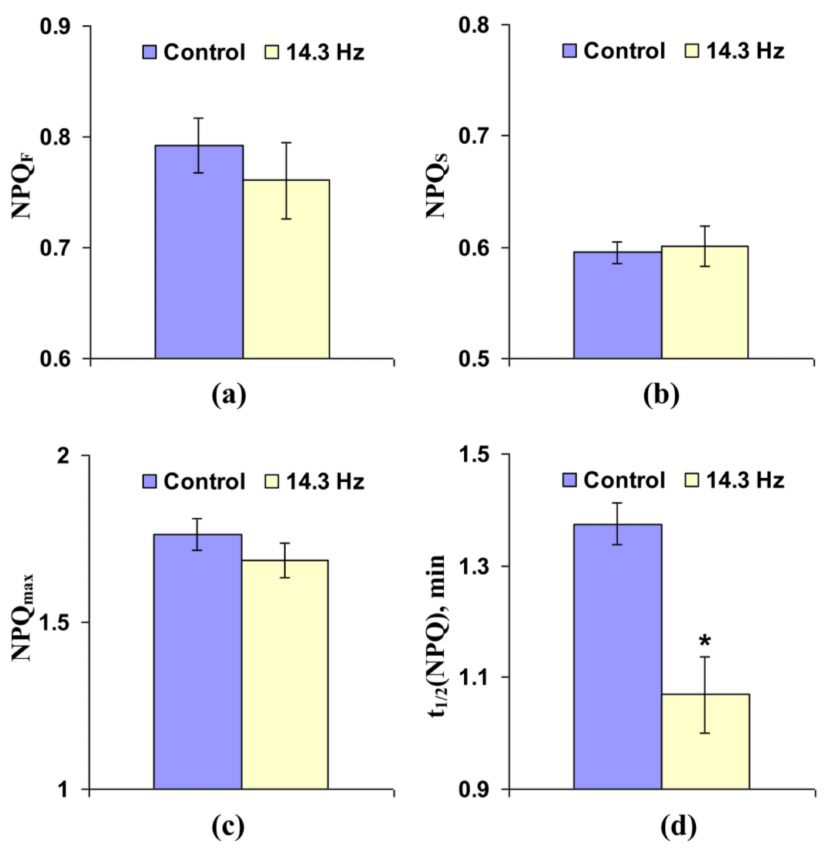
Figure 8. Influence of chronic treatment by artificial extremely low frequency magnetic field on fast-relaxing component of non-photochemical quenching under illumination (NPQ F ) ( a ), slow- relaxing component of non-photochemical quenching after this illumination (NPQ S ) ( b ), maximal value of non-photochemical quenching (NPQ max ) ( c ), and time taken for 50% increase of NPQ under illumination (t 1/2 (NPQ)) ( d ) in wheat seedlings ( n = 30). Chronic action of the artificial magnetic field was initiated from soaking of seeds. Magnitude of the magnetic field was 18 µ T; frequency was 14.3 Hz. Photosynthetic parameters were measured by the action of this field. Control plants were not treated by this artificial magnetic field. *, difference between the experiment and control plants was significant ( p <